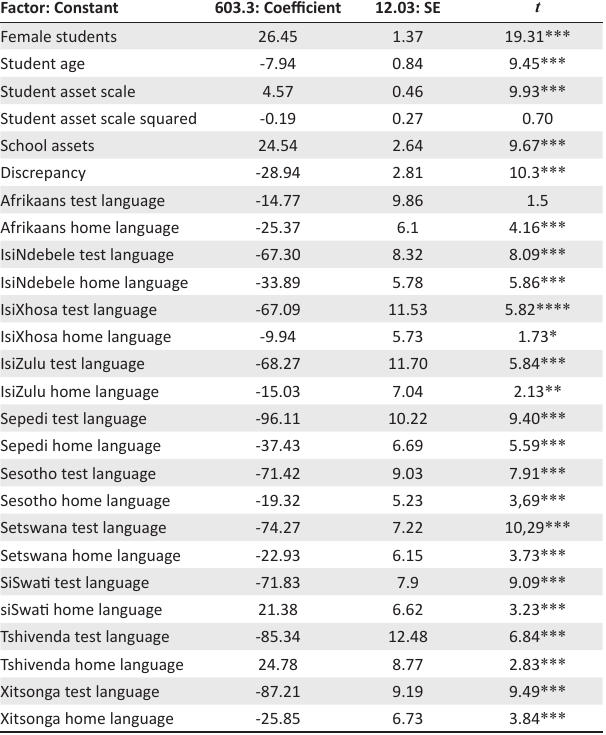
TABLE 5: Model results for the discrepancy between language of the test and home language, membership to a language group outside the language of the test.